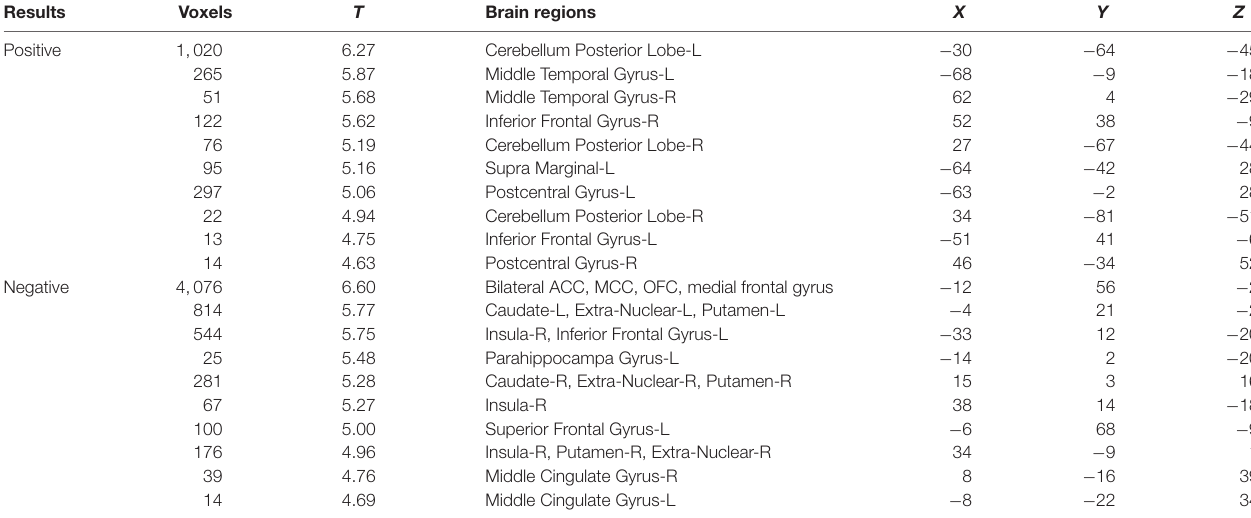
TABLE 2 | VBM analyses of relationships between BMI and GMV: whole sample. Results